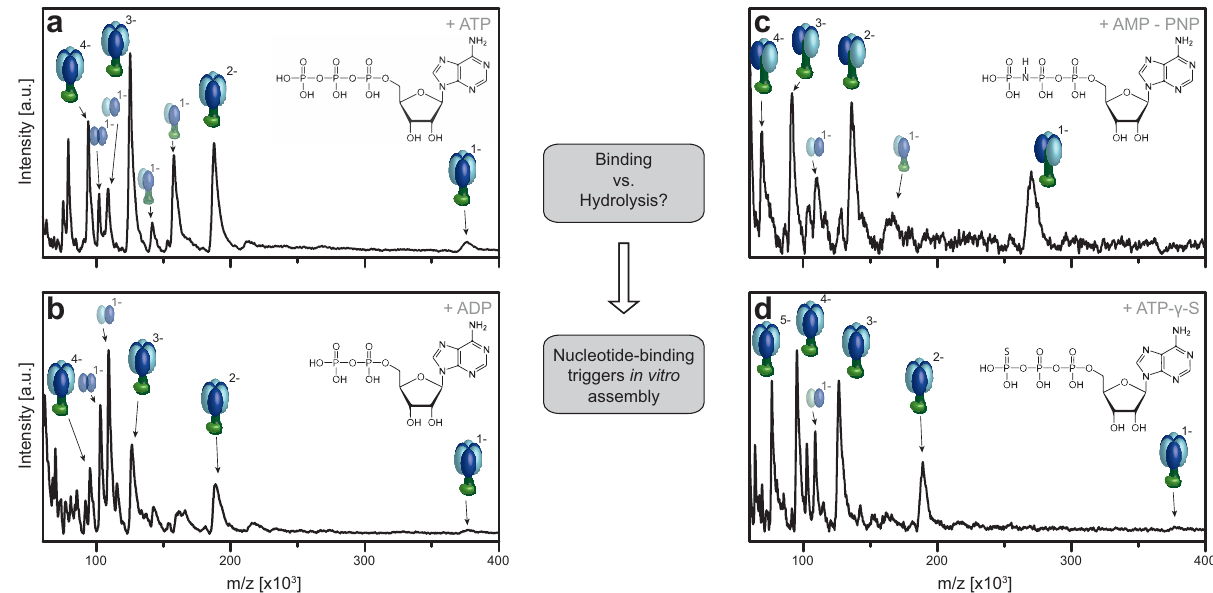
Fig. 4 Role of ATP hydrolysis vs . nucleotide-binding in the assembly process to F 1 of bacterial F-type ATP synthases. LILBID spectra of in vitro α , β , γε assembly: The α - (light blue), β -subunit (dark blue), γε -complex (dark and light green) were incubated with 2 mM MgCl 2 and 2 mM of a nucleotide at 4 °C for 1 h. Complex formation is observed after incubation with ATP ( a ), AMP-PNP ( b ), ADP ( c ), and ATP- γ -S ( d ). Full α 3 β 3 γε assembly can be identi fi ed next to small amounts of other F 1 subcomplexes (e.g., α 2 β 2 δγε α 2 β 2 γε , αβγε , αβγ ), for ATP as well as the non-hydrolysable ATP analogs, apart from AMP-PMP, where the highest observed complex is α 2 β 2 γε . Source data are provided as a Source Data fi